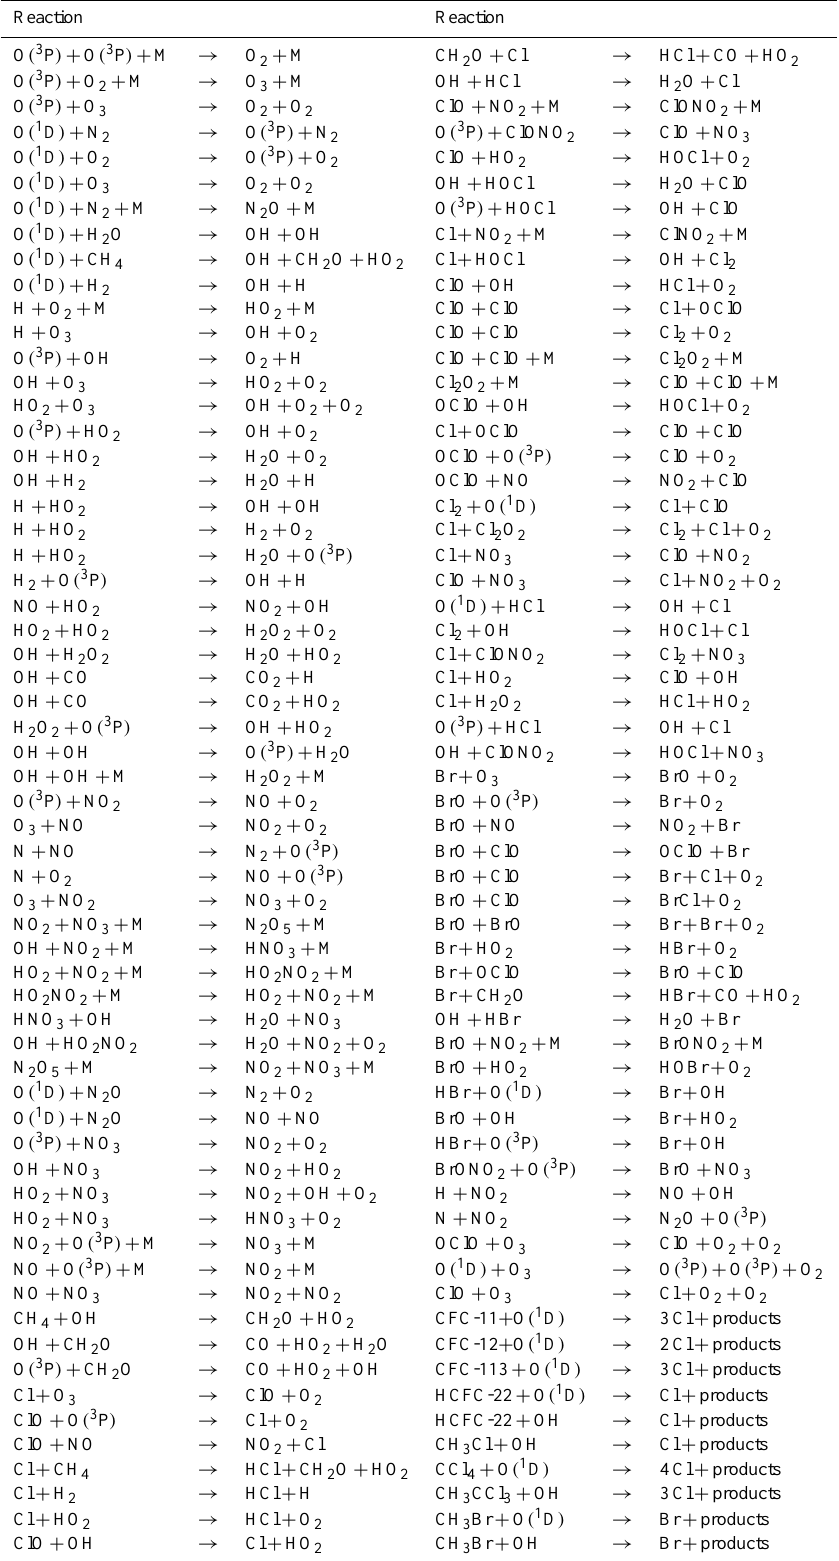
Table 3. List of gas phase